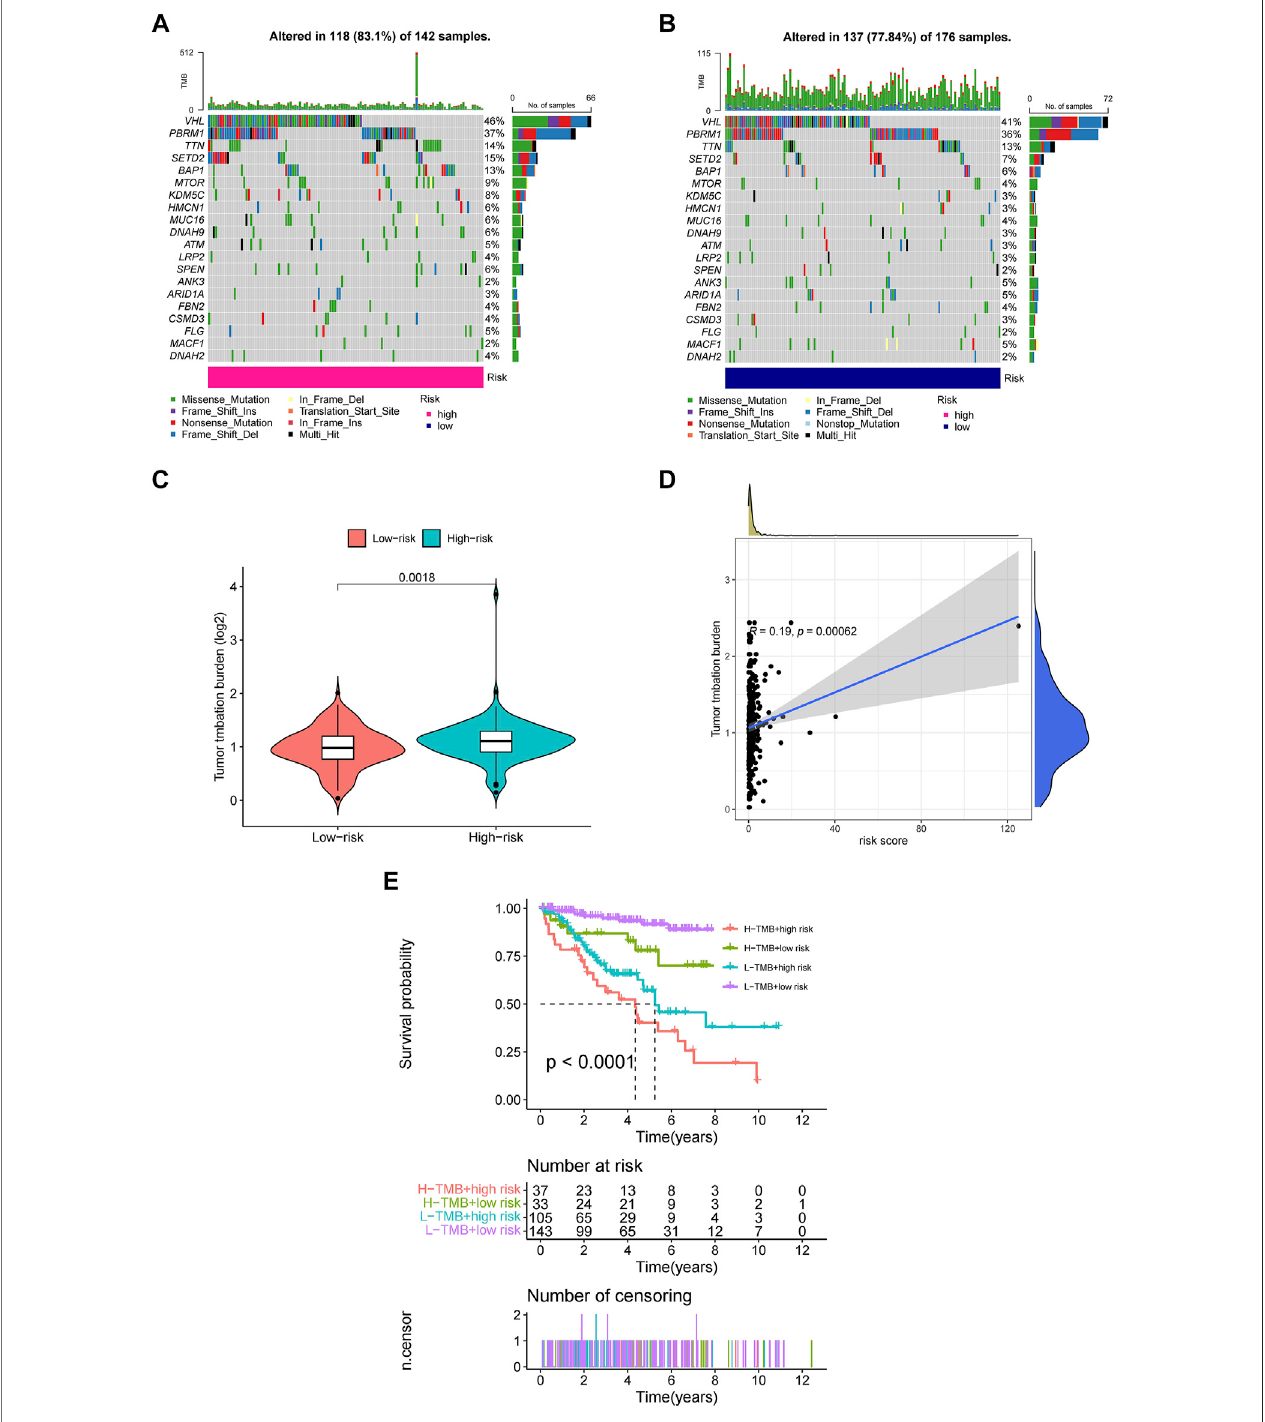
FIGURE 8 | The investigation of tumor mutation burden (TMB) (A,B) TMB in the high-risk and low-risk group, respectively. (C) The comparison of TMB between two groups (D) Correlation between TMB and risk scores (E) The survival curve strati fi ed by TMB and risk signature.